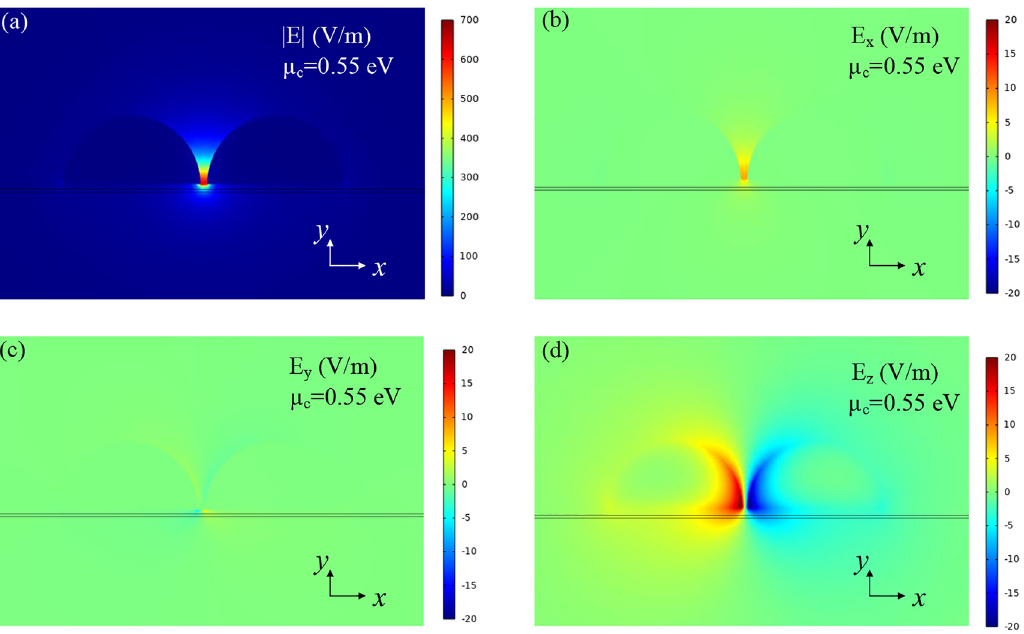
Figure 3: Simulated electric field distributions on the xy plane of the GPM with μ c = 0.55 eV. (a)Electricfieldmagnitude | E | .(b)Electric fi eldcomponentin x -direction(E x ).(c)Electric fi eldcomponentinthe y -direction(E y ).(d)Electric fi eld component in z -direction (E z ).